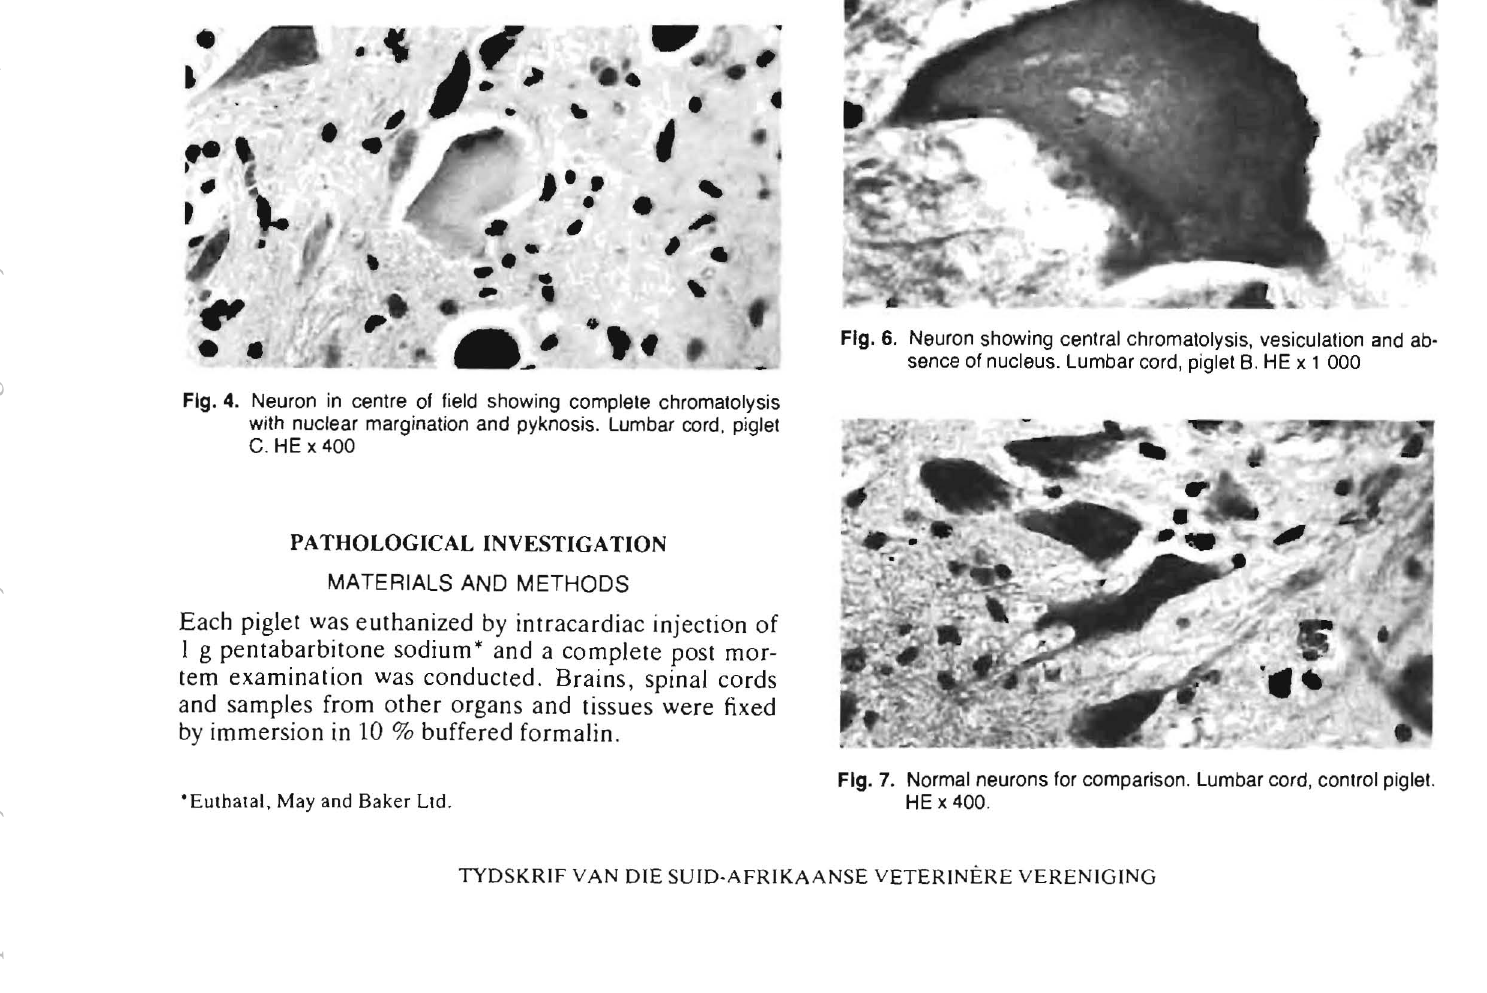
TYDSKRIF VAN DIE SU/D-AFRIKAANSE VETERINERE